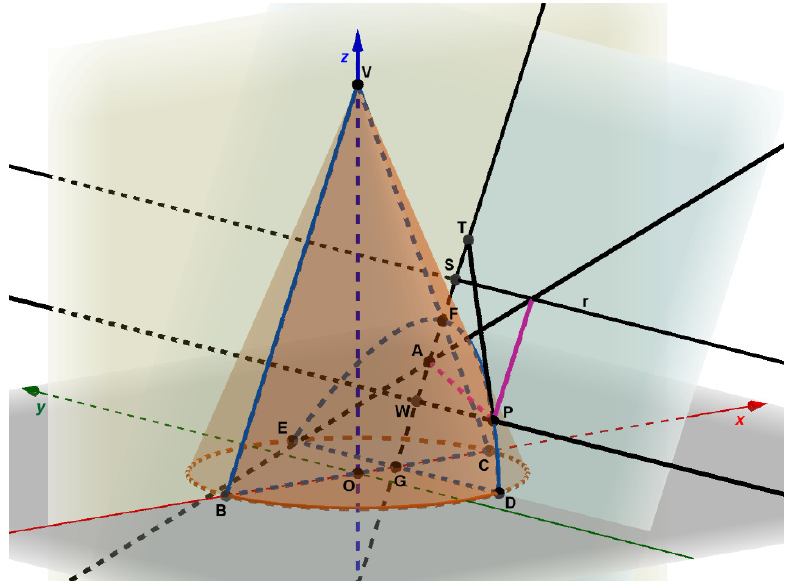
Figure 6. Through a slider in GeoGebra (not shown here), it is possible to show that the distance of a generic point 𝑃 of the parabola from the directrix 𝑟 is the same as the distance from the focus 𝐴 .